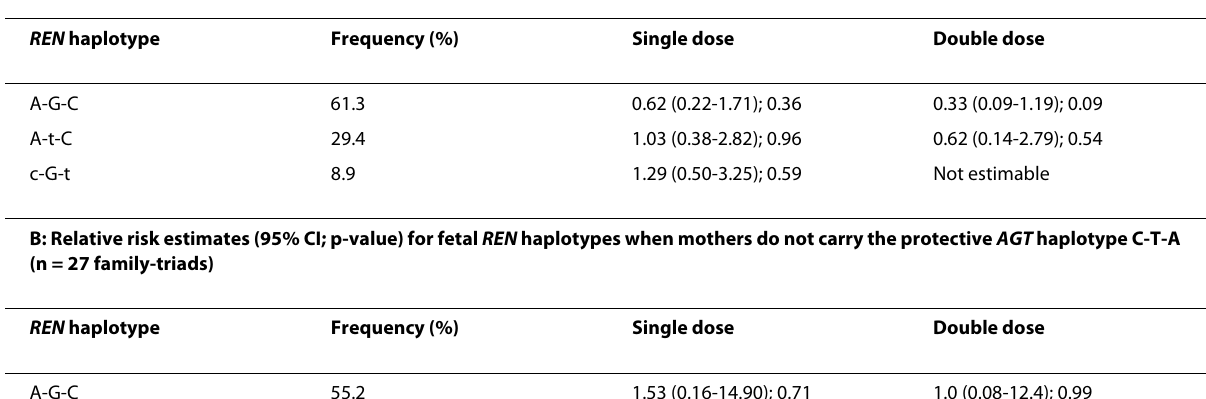
Table 3: Relative risk estimates for REN and AGT interactions: A: Relative risk estimates (95% CI; p-value) for fetal REN haplotypes when mothers carry the protective AGT haplotype C-T-A (n = 57 family-triads)